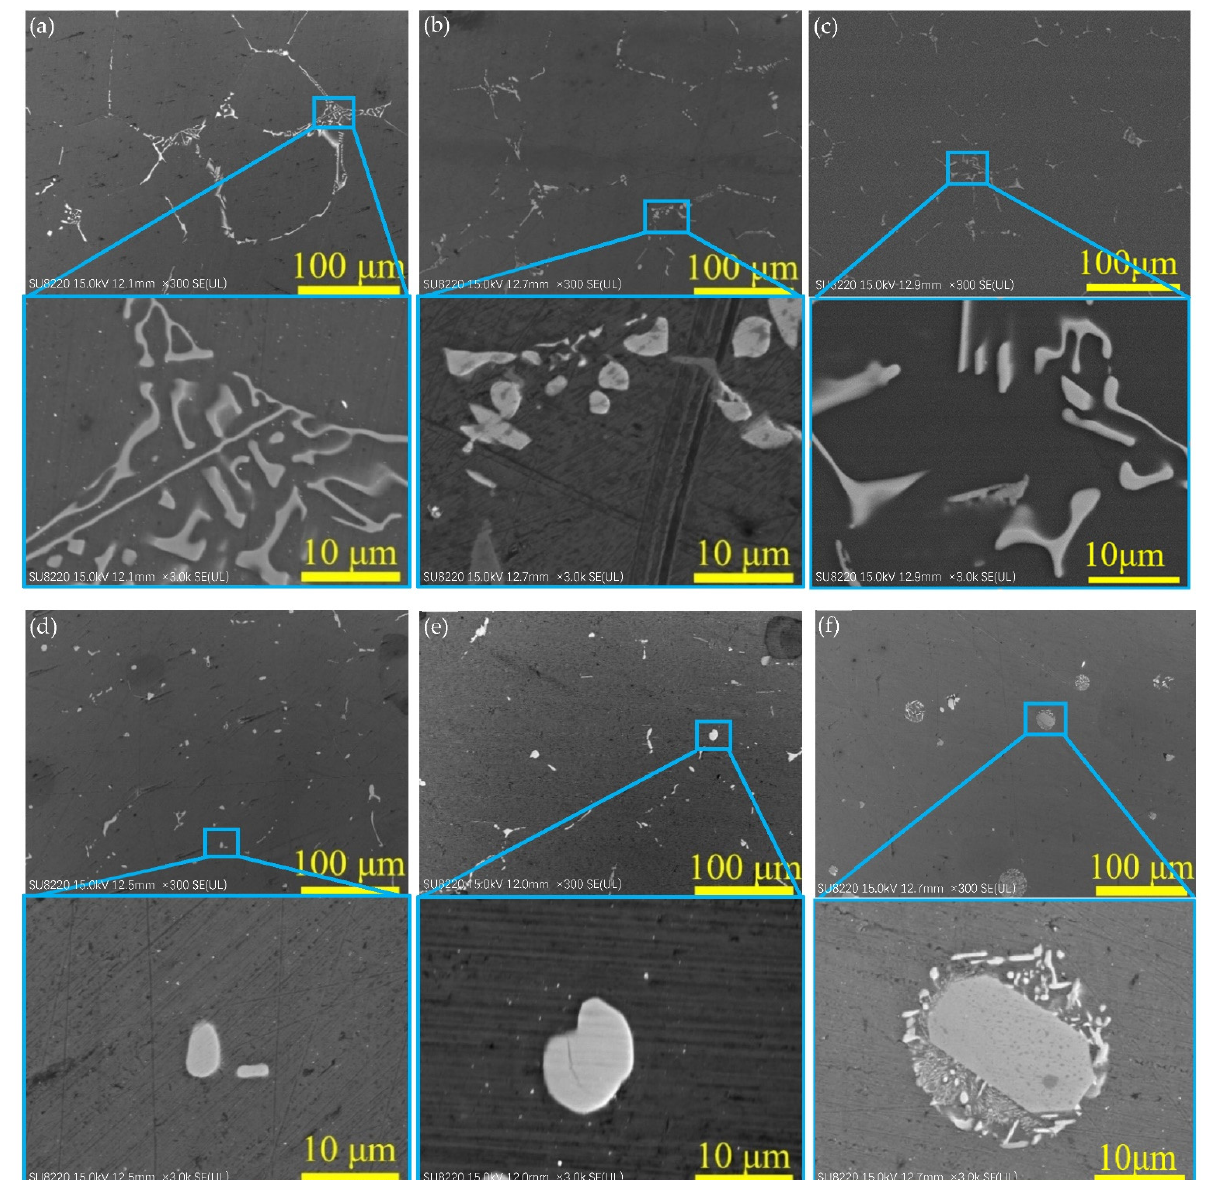
Figure 6. Microstructure evolution process of Al-5Zn-0.03In-1Er alloy during different temperature: ( a ) As-cast, ( b ) 585 °C, ( c ) 595 °C, ( d ) 605 °C, ( e ) 615 °C, ( f ) 625 °C. With the UHTT temperature increasing, in Figure 6 the amount of interdendritic eutectic microstructure in the alloy gradually decreased compared with that of the as-cast state. The net-like interdendritic phase segregation compound was no longer continuous. The precipitate at the grain boundaries became sparse. After UHTT at 605~615 °C for 24